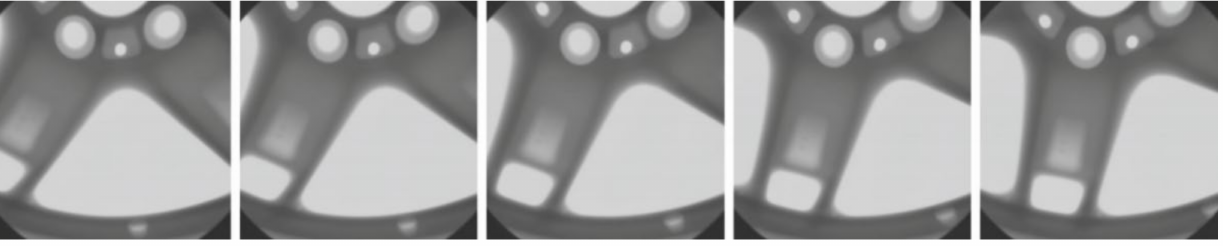
Figure 7. Selected images from GDXray’s database [42].